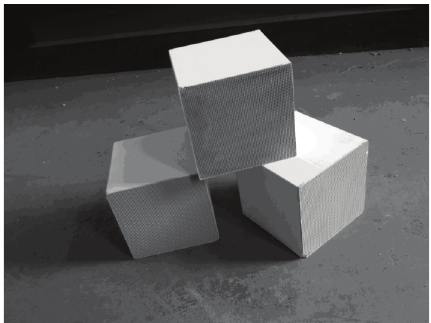
Figure 4: Catalytic ceramic monolith